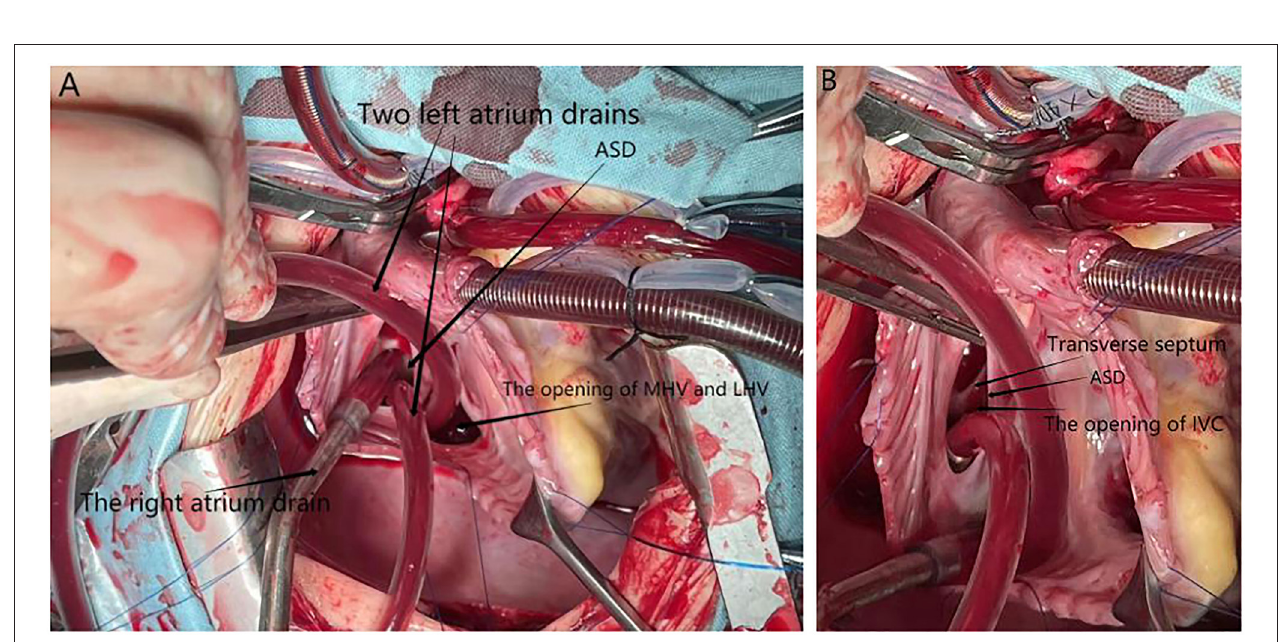
FIGURE 3 | An intraoperative photograph (after the RA was cut off). (A) ASD, the opening of LHV and MHV, two left atrium drains, and one right atrium drain are indicated by black arrowheads. (B) Transverse septum at the orifice of the inferior vena in the left atrium and the opening of the inferior vena cava are indicated with black